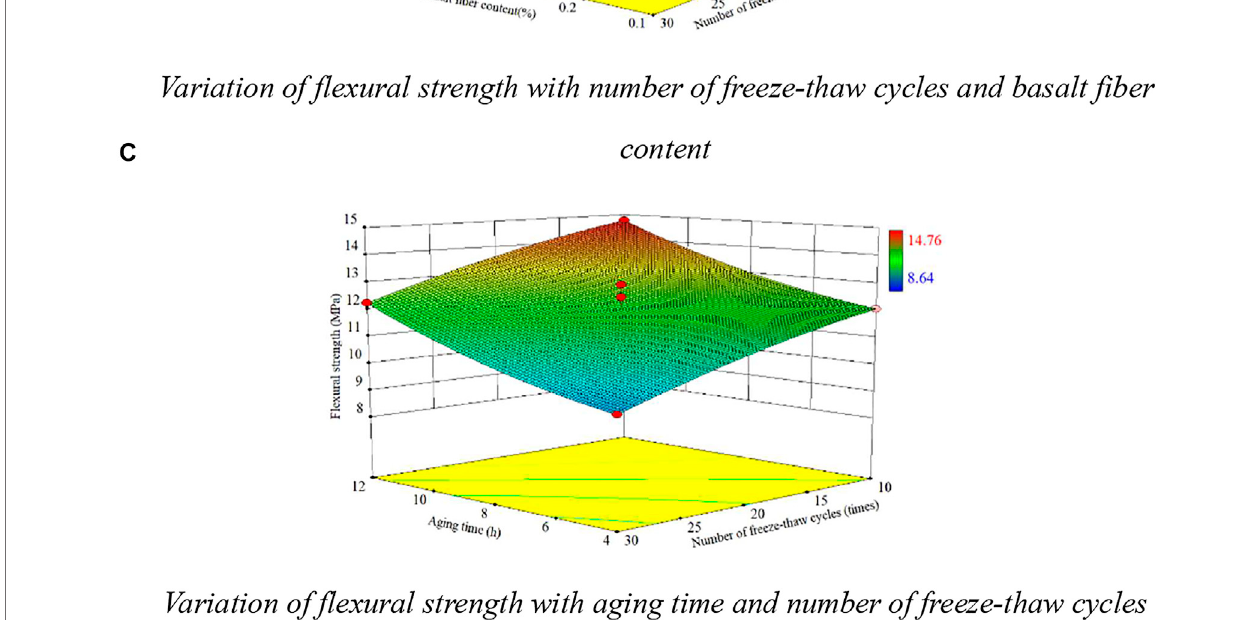
Frontiers in Materials |